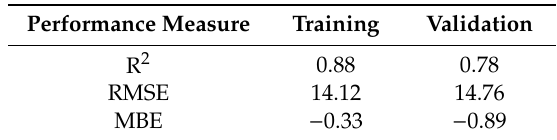
Table 1. Performance criteria of the generalized regression neural network (GRNN) model for in vitro shoot regeneration of wheat in training and validation processes.